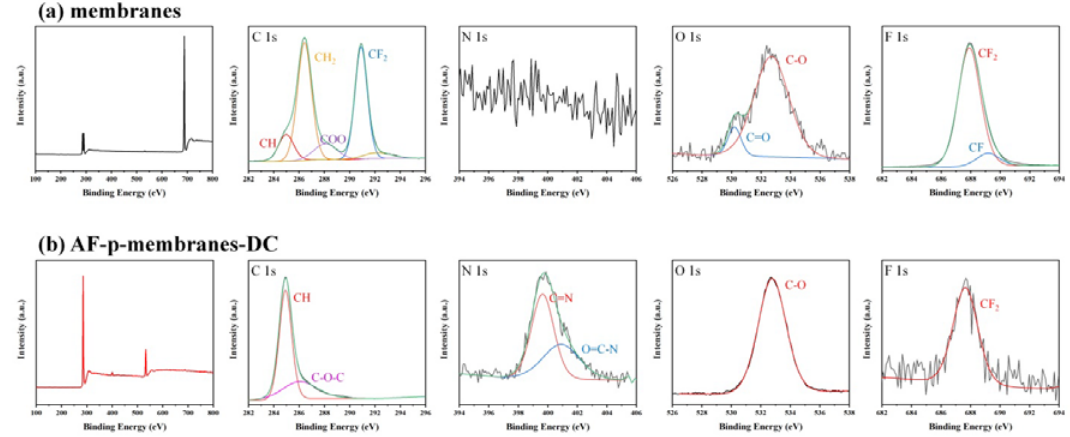
Figure 9. X-ray photoelectron spectroscopy (XPS) of ( a ) membranes and ( b ) AF-p-membranes-DC.